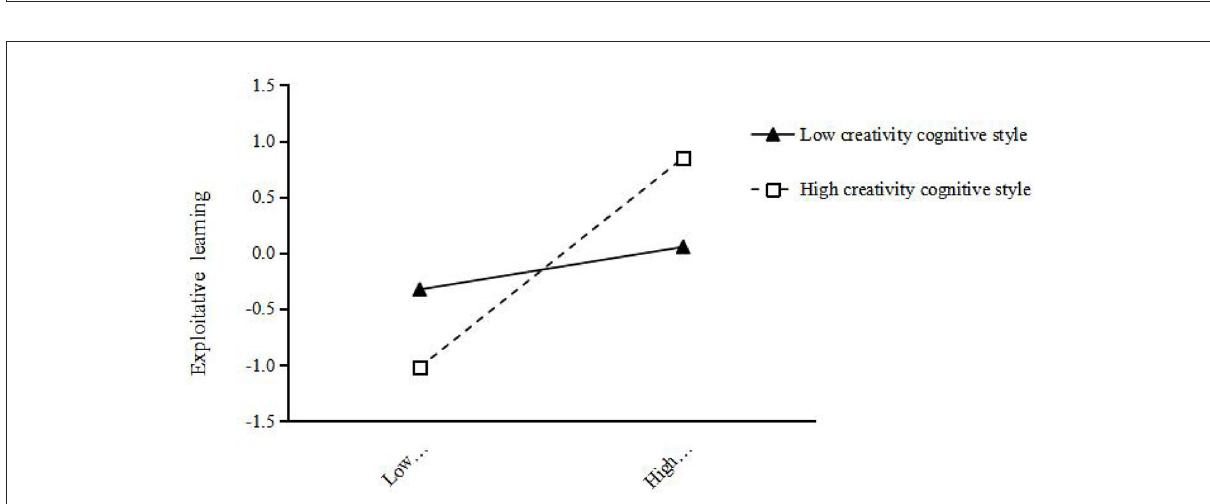
FIGURE3 Regulatory effect of creativity cognitive style on the indirect relation between exploitative learning and supervisor creative feedback